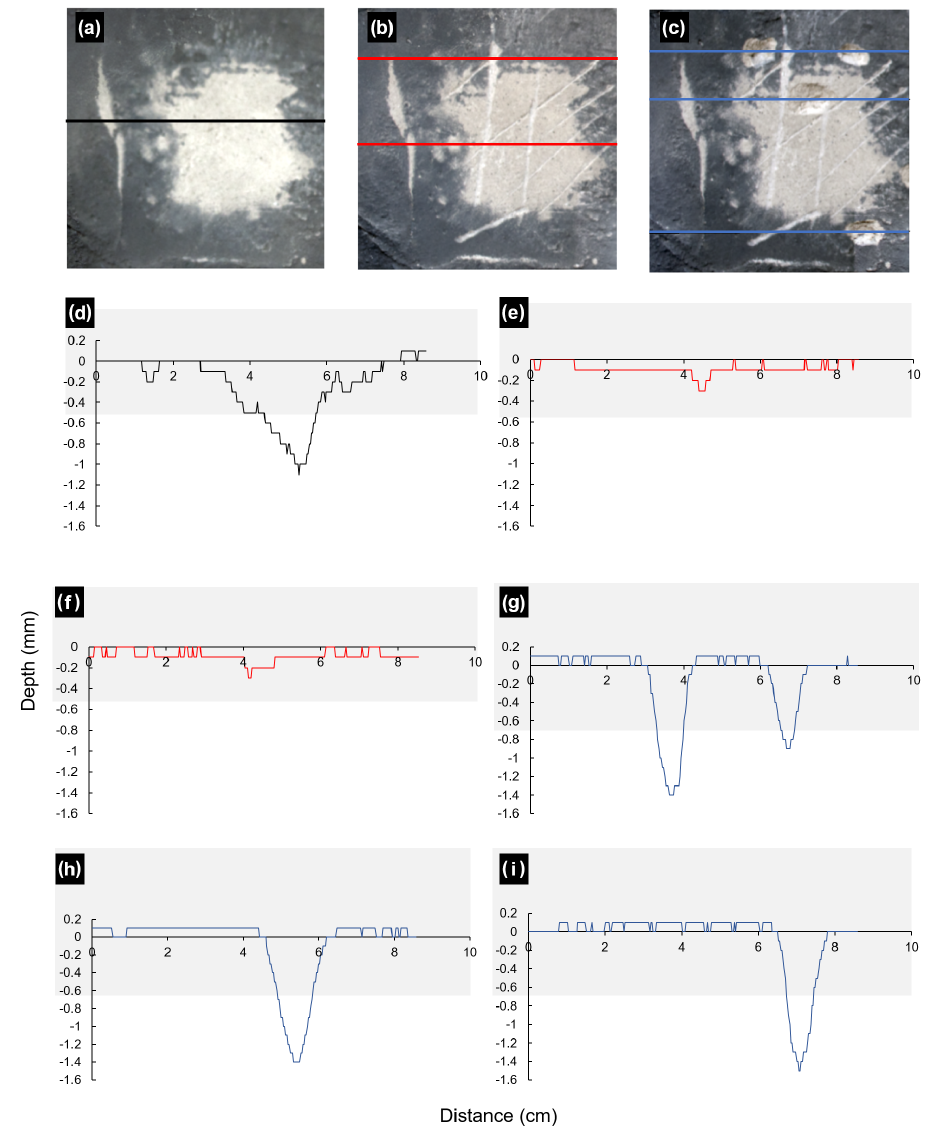
Figure 4. Location and topographic profiles of “erosion” features on the simulated platform surface of B1 for (a) Stage 1 (profile shown in d ), (b) Stage 2 ( e and f , top and bottom respectively shown in b ), and (c) Stage 3 ( g , h , and i , top, middle, and bottom profiles respectively shown in b ). Grey shaded areas in (d) – (i) show the